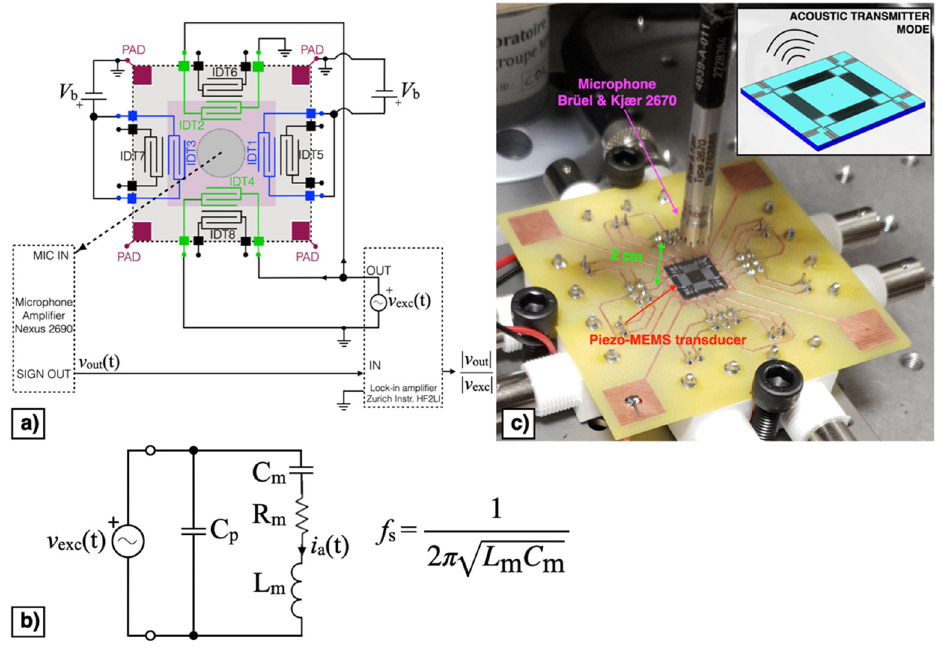
Figure 14. Block diagram ( a ), equivalent BVD model ( b ) and experimental set-up ( c ) of the piezoelectric MEMS device in acoustic transmitter mode.